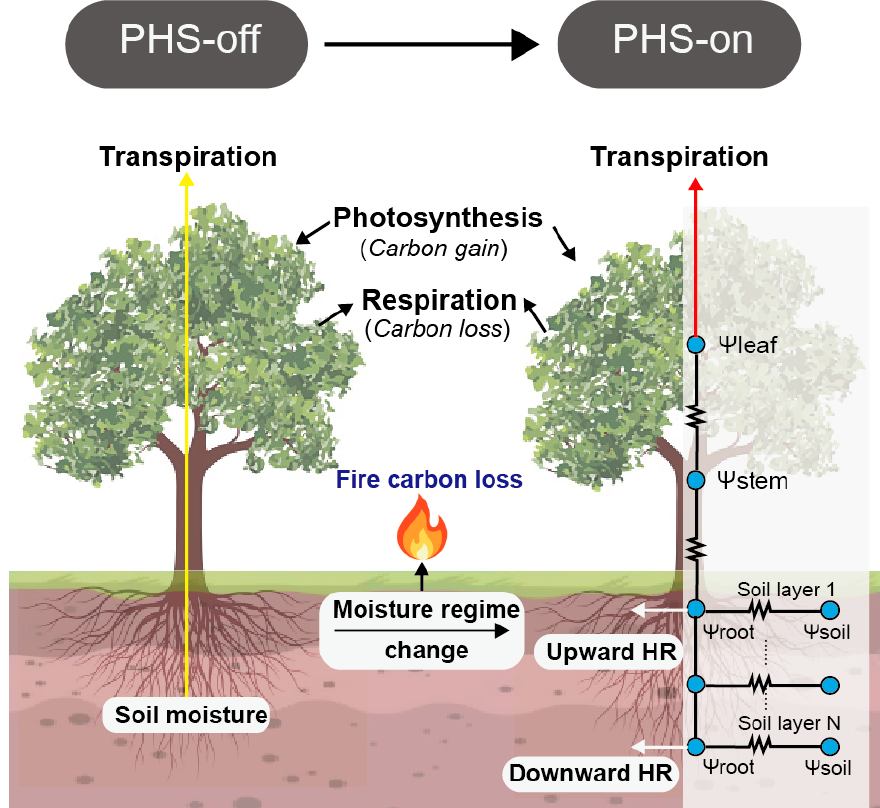
Figure 1. Plant water flow and status in CLM5 without (PHS-off) and with (PHS-on) plant hydraulic stress configuration. The PHS configuration simulates water potential ( ψ ) at the leaf, stem, root, and soil levels. HR represent hydraulic redistribution of soil water by roots.